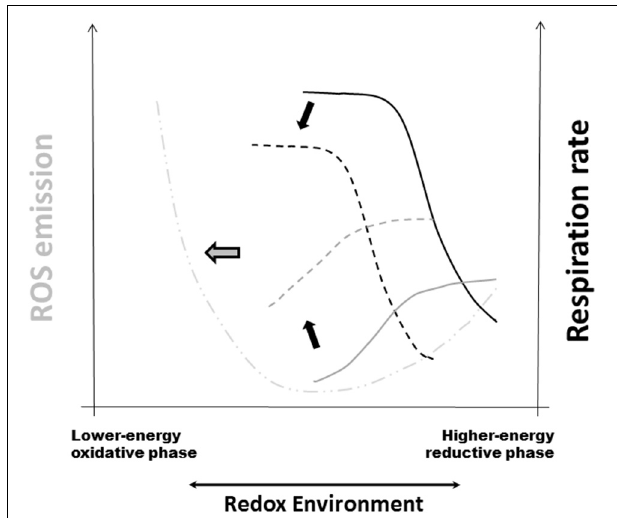
FIGURE 2 | Redox-Optimized ROS Balance and the effect of oxidative stress on mitochondrial respiration, H 2 O 2 emission, and the RE. R-ORB postulates that ROS levels (as the net result of production and scavenging) depend on the intra-cellular and -mitochondrial redox environment (RE). It also proposes that there is a minimum level of ROS emission when mitochondria maximize their energetic output. Under high energy demand, and despite large respiratory rates, ROS emission levels will be kept to a minimum by ROS scavenging systems (Stanley et al., 2011; Aon et al., 2012). Oxidative stress can happen at either extreme of RE, either highly reduced or highly oxidized, but governed by different mechanisms (Aon et al., 2010; Kembro et al., 2014). The plot displays schematically the summary of the response of respiration (black traces) and ROS emission in stressed mitochondria (gray traces) plus further addition of the uncoupler FCCP (dashed-dotted line). Continuous lines correspond to the absence of stress whereas dashed lines belong to mitochondria under stressed conditions (Cortassa et al., 2014). Black arrows indicate the direction of change in VO 2 and ROS elicited by stress. Notice the shift toward more oxidized RE in the curves corresponding to stressful conditions. The thick gray arrow pointing to the left denotes pathological conditions arising, e.g., from chronic diseases, where severe stress will affect both energetic (e.g., (cid:2)(cid:3) m , ADP consumption) and redox [e.g., NAD(P)H, GSH, Trx] functions thus increased mitochondrial ROS emission and higher cytoplasmic ROS levels. Reprinted from Cortassa et al.